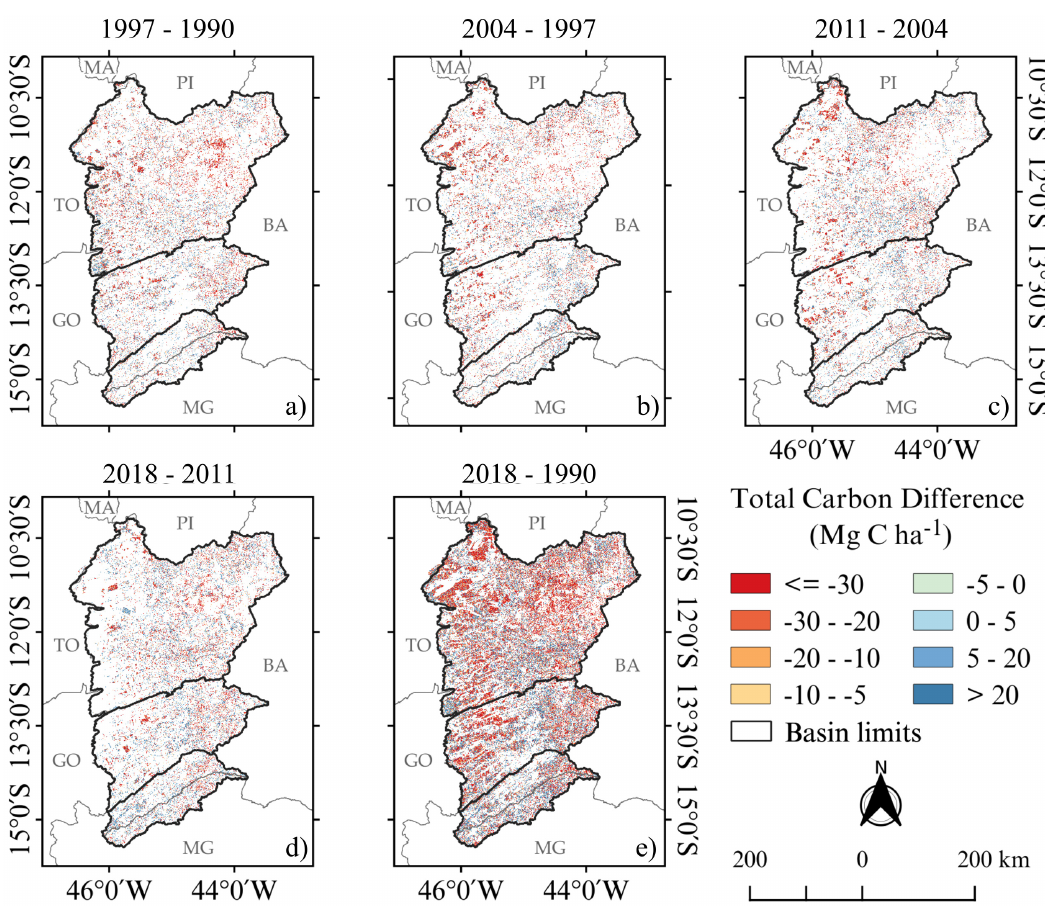
Fig 3. Differences in total carbon stocks for Western Bahia. Carbon stocks in Mg-C ha − 1 for (a) 1997 − 1990, (b) 2004 − 1997, (c) 2011 − 2004, (d) 2018 − 2011, and (e) 2018 − 1990. This figure was made using open source geographic information system (QGIS) and open data source: watersheds vector lines were obtained from OBahia (http://obahia.dea.ufv.br) and geopolitical borders were obtained from IBGE